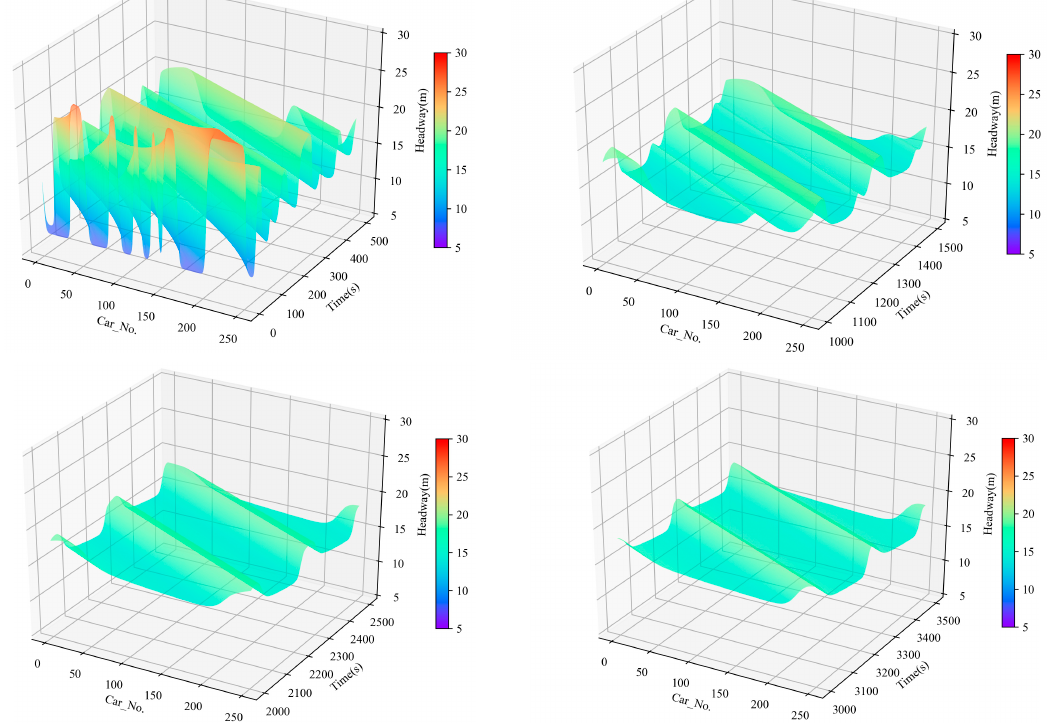
Figure 7. Evolution of headway with non-uniform vehicle distribution: the parameters of the DAVD model is β = 0.2, p = 0.2, m = 5.